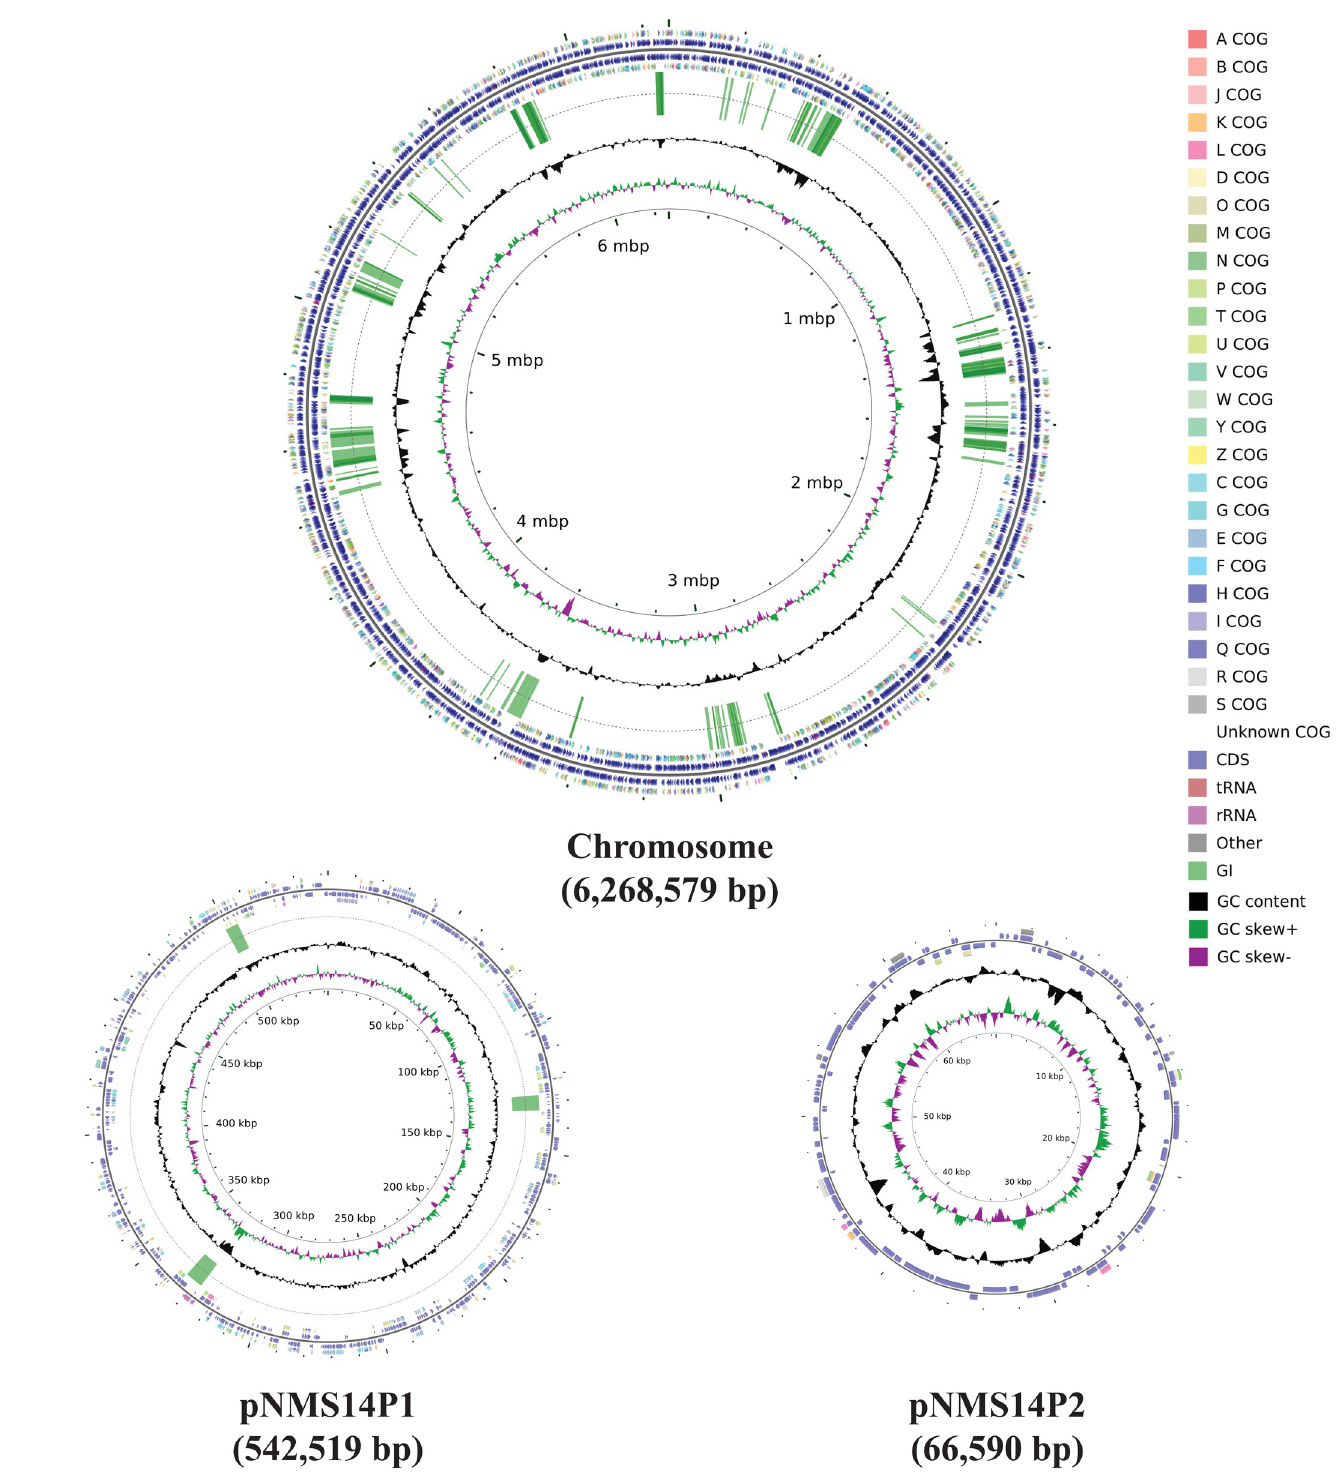
Fig 2. Schematic representation of the three circular replicons of NMS14P. The circles from inside to outside: GC skew positive (green) and negative (purple), GC content (black), genomic islands (GIs) (no GI was identified in pNMS14P2), color-coded COG functional categories for reverse strand CDSs, reverse strand sequence features, forward strand sequence features, and color-coded COG functional categories for forward strand CDSs.